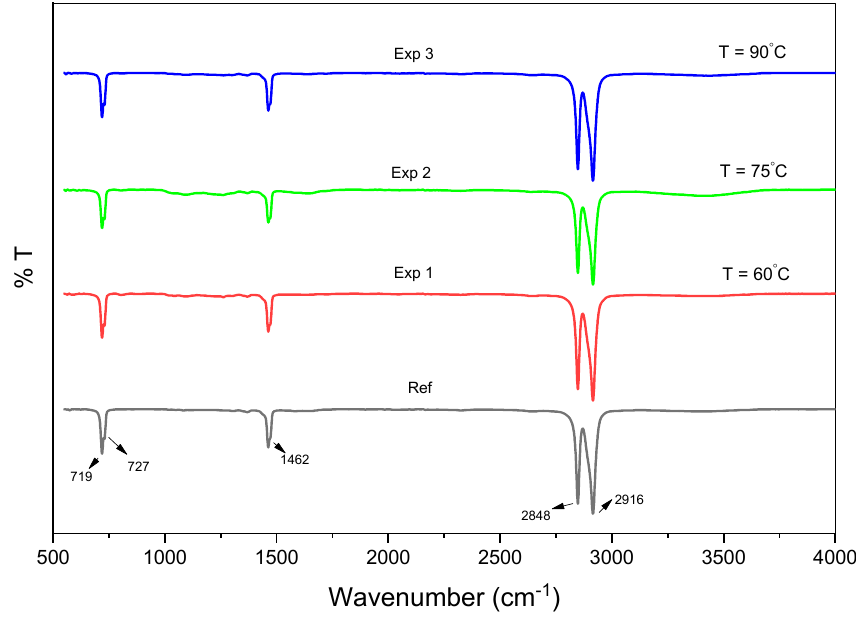
Figure 3. FTIR spectra for virgin and aged samples.